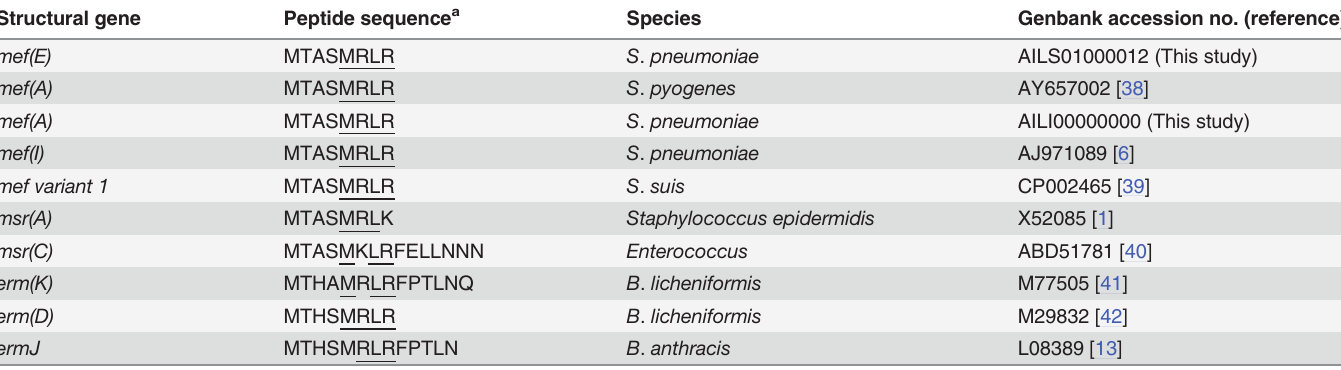
Table 3. Putative leader peptide sequences of inducible macrolide resistance genes. Structural